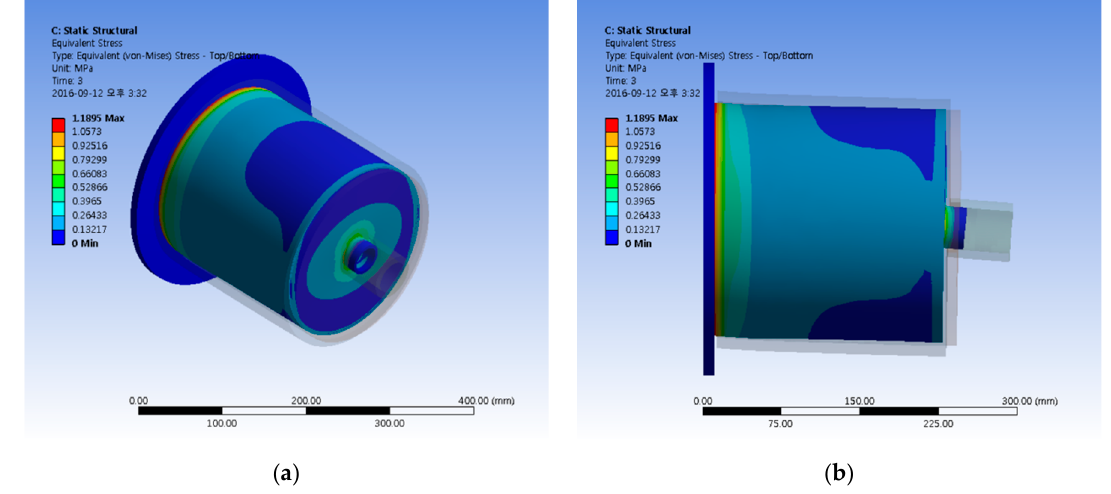
Figure 21. Stress contour on the magnet coupler. In this case, the bulkhead wall thickness is 4 mm and the blade/hub assembly weight 1100 N. ( a ) The isometric view of the stress contours. ( b ) The side elevation of the model also the highest stress region occurs near the base of the bulkhead.